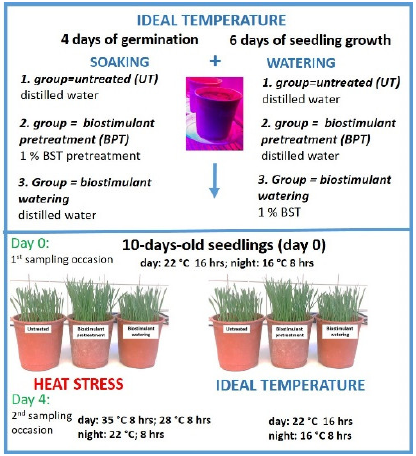
Figure 5. Plant growing, temperature conditions and biostimulant treatments.